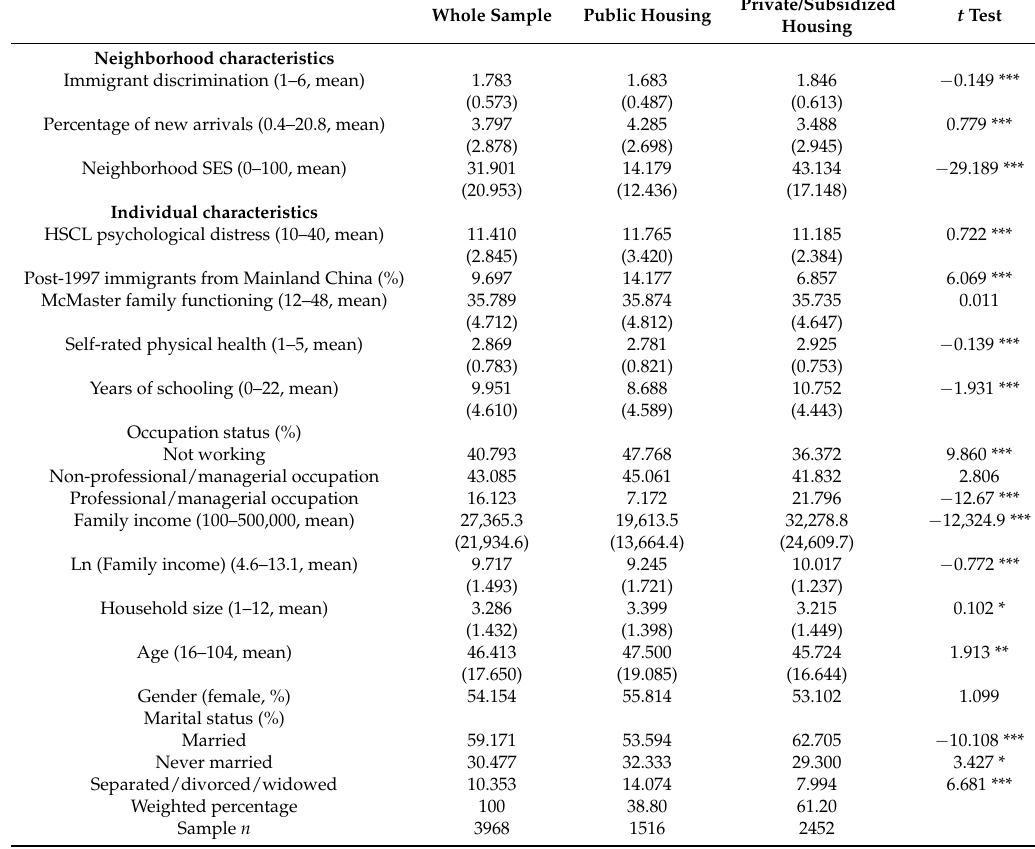
Table 1. Descriptive Statistics of the Whole Sample and by Housing Type Whole